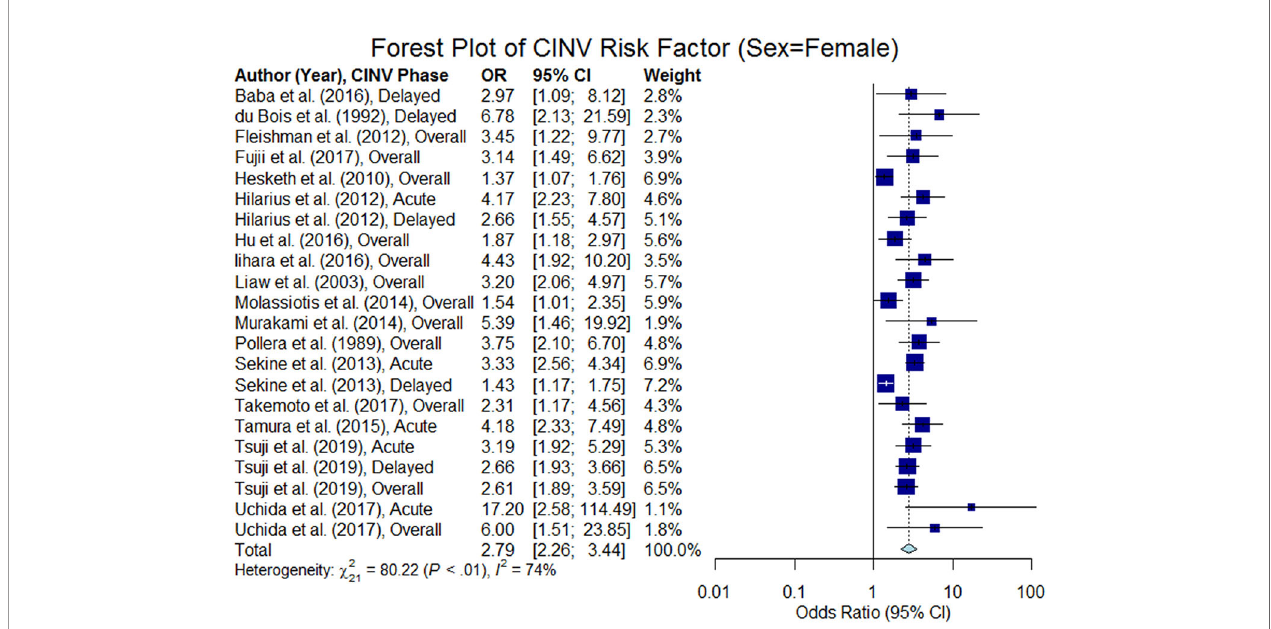
FIGURE 4 | Forest plot of Chemotherapy-Induced Nausea and Vomiting (CINV) risk factor (sex = female).